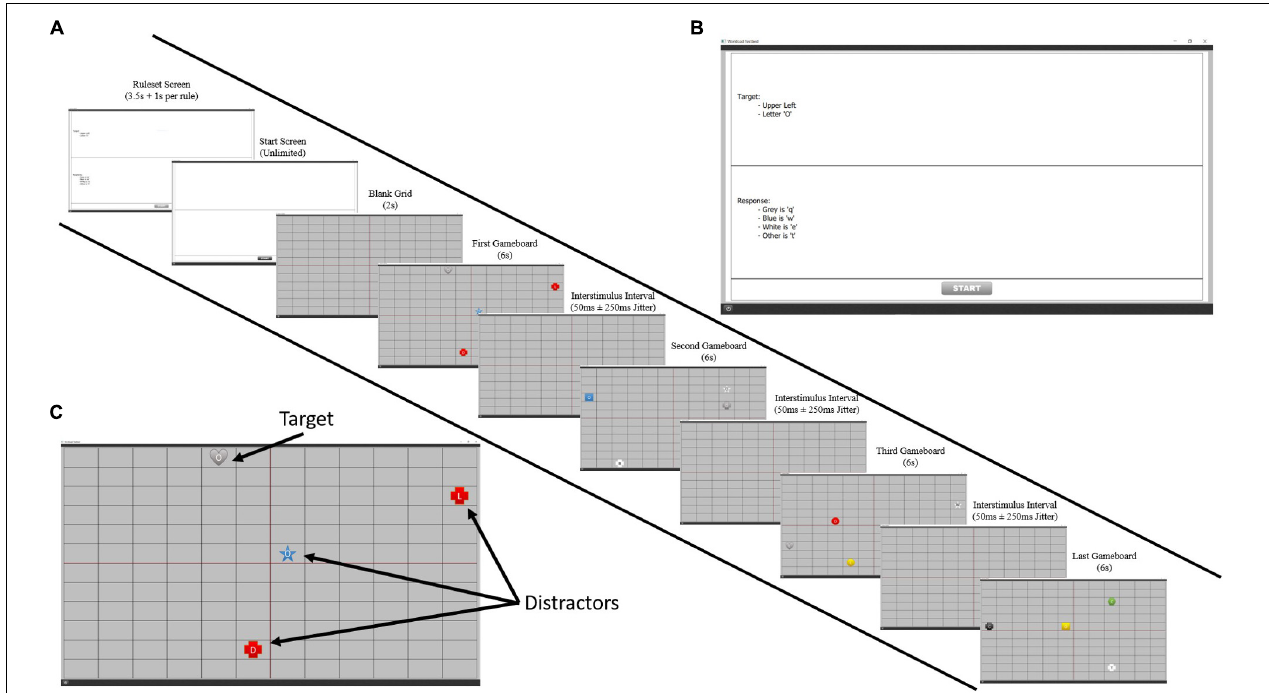
FIGURE 1 | A visual representation of the ISR task. (A) Progression of an example ISR level. Participants were presented with a ruleset for that level on the first screen which disappeared after a short duration. Participants had to remember these provided rules throughout the entire level for accurate target identification and response. After pressing the start button on the following screen, they would play four boards using this ruleset. (B) An example of a level ruleset. (C) Example of an ISR board. On each board, participants saw four stimuli and had to use the mouse to select the target based on the target identification rules and press the appropriate letter on the keyboard based on the target response rules. Based on the ruleset shown in panel (B) , a correct response would be to click gray heart with an “O” and pressing the letter “q” on the